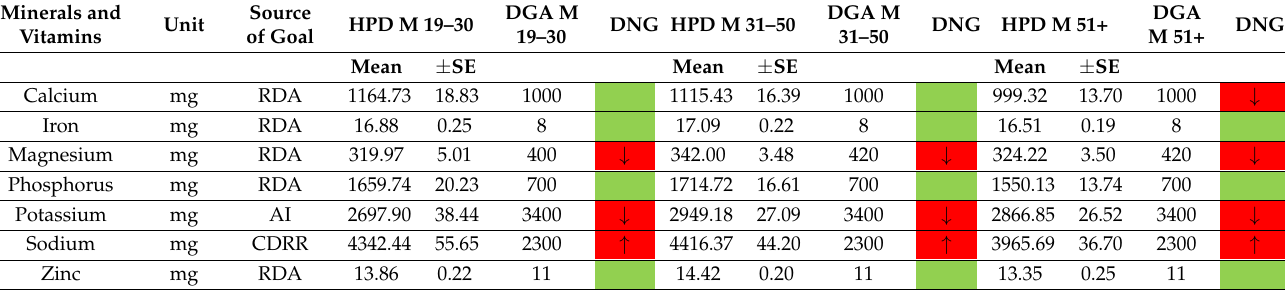
Table 8. Mineral and vitamin intake in males following an HPD compared to the DNG in